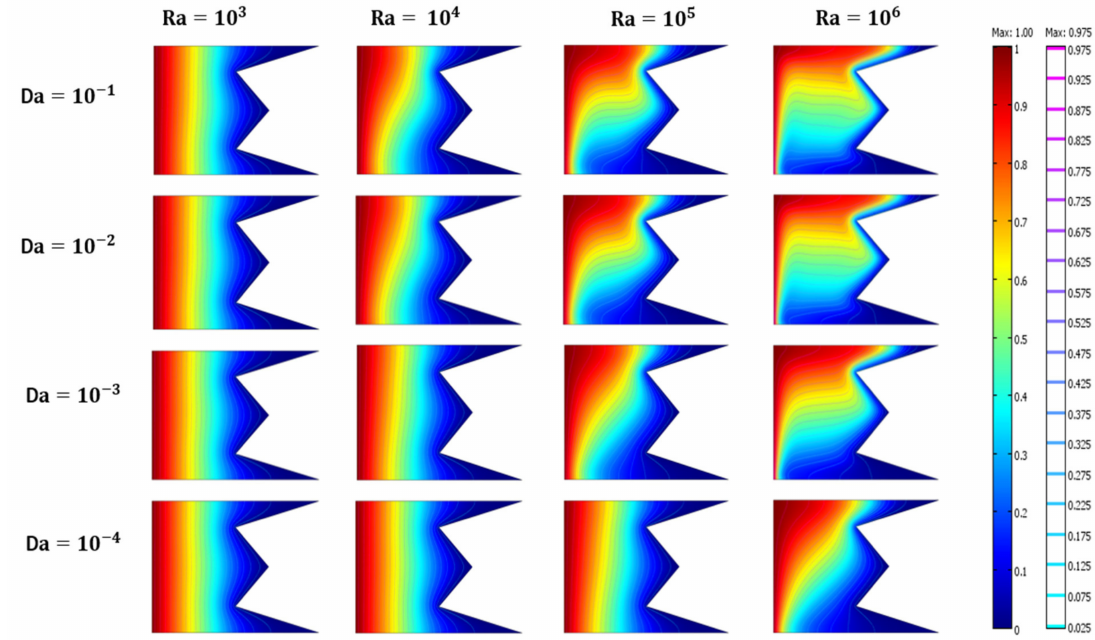
Figure 9. Isotherms for di ff erent values of Darcy numbers (Da = 10 − 4 , 10 − 3 , 10 − 2 and 10 − 1 ) and Rayleigh numbers (Ra = 10 3 , 10 4 , 10 5 and 10 6 ), Ha = 15, AR = 0.3, ω = 0, ϕ = 0.04, Fr = 0.75 and q ∗ =